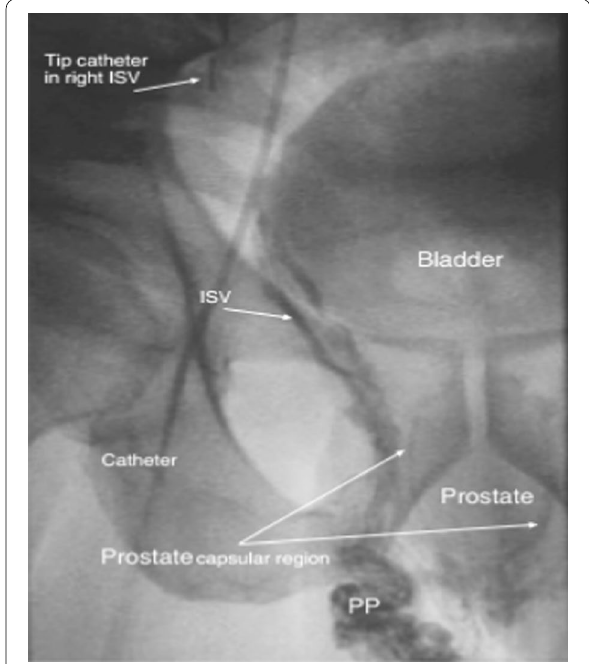
Fig. 2 A prostatic capsular contrast ‘blush’ (long arrows) following spermatic venous opacification confirms the backdoor phenomenon [7] “Copyright (2022) Wiley. Used with permission from (Gat and Goren, Benign prostatic hyperplasia: Long-term follow-up of prostatic volume reduction after sclerotherapy of the internal spermatic veins, Andrologia, Wiley)” (pp pampiniform =